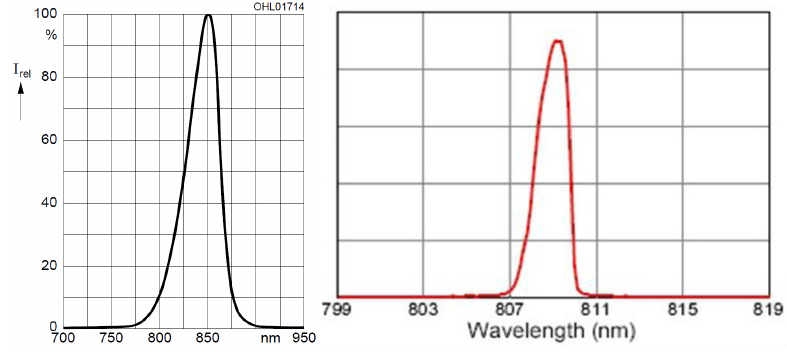
Figure 4. Emission spectrum of the 850nm near infrared (NIR) LEDs ( left ) and the NIR laser modules ( right ), taken from the data sheet